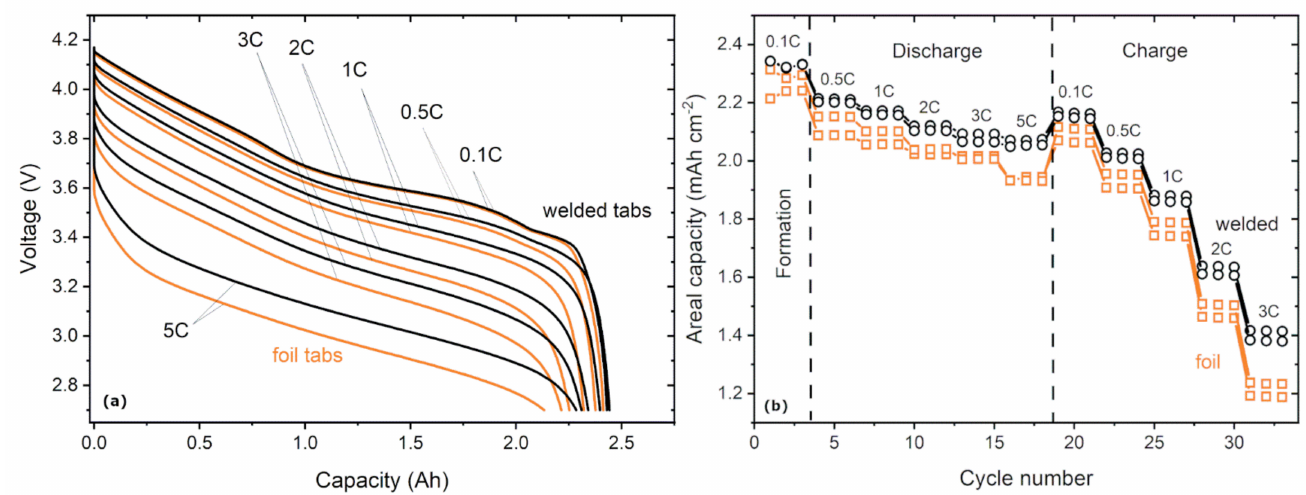
Figure 3. Comparison of cell performance of pilot-scale 21700 Li-ion cells with foil tabs vs. conventionally welded tabs. ( a ) Discharge voltage curves of discharge rate capability test. ( b ) Discharge areal capacity for formation, discharge and charge C-rate capability